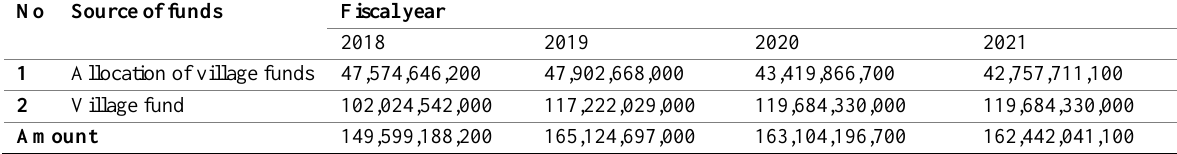
Table 1: Village Fund Actualization Data of Simeulue